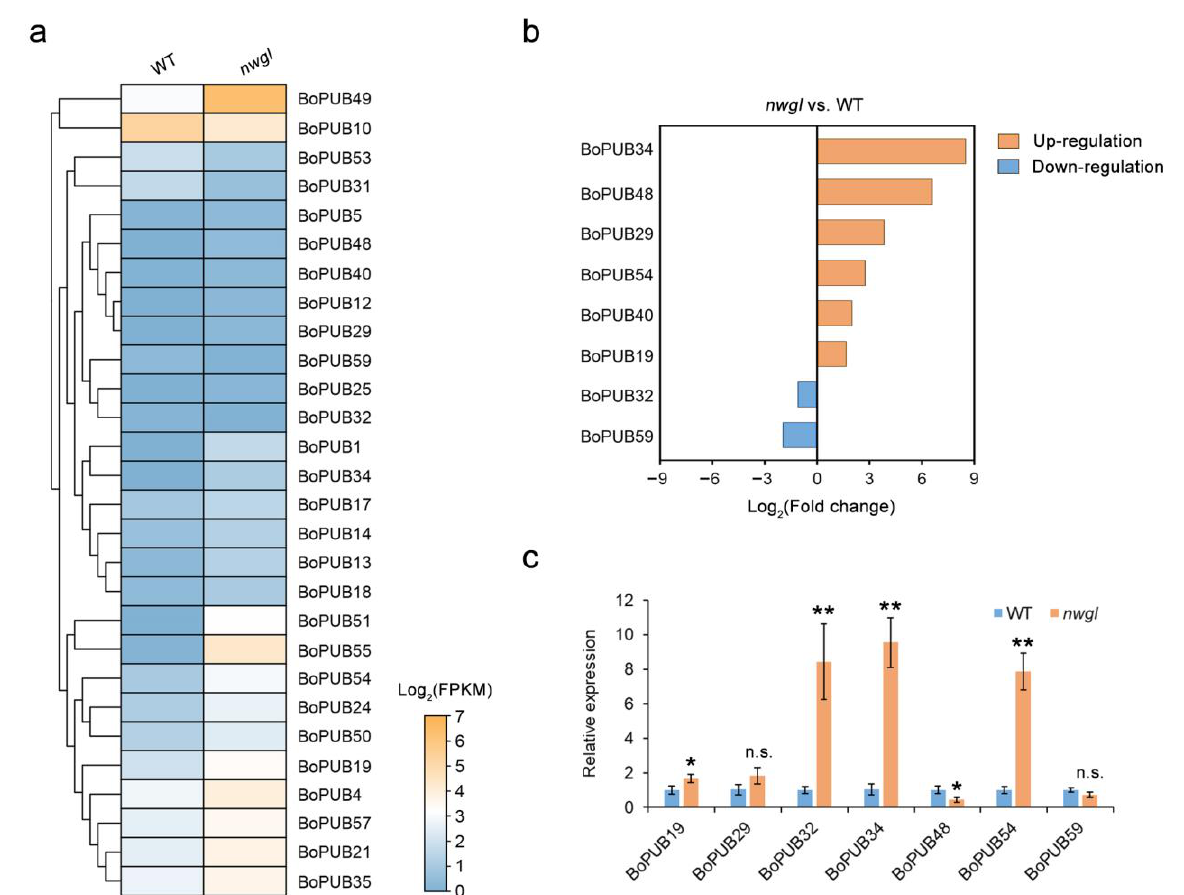
10 of 22 Figure 6. Expression profiles of BoPUB genes in various tissues and organs. The normalized expres- sion data, as fragments per kilobase per million mapped reads (FPKM), of BoPUB genes in seven tissues, including callus, root, stem, leaf, bud, flower, and silique, were obtained from the RNA-seq data of cabbage ( Brassica oleracea var. capitata ). The expression levels of BoPUB genes were plotted in a log2-scaled heatmap. Each row and column in the color heatmap indicate a single gene and tissue, respectively, and their names are shown. Sixty-five BoPUB genes are hierarchically clustered into six groups (Groups I–VI) according to their expression levels. Groups I–VI are highlighted in six different colors, respectively. 2.7. Expression Patterns of BoPUB Genes Involved in Cuticular Wax Biosynthesis E3 ubiquitin ligases have been widely reported to regulate cuticular wax biosynthesis in many species, including Arabidopsis thaliana [38,39] and Oryza sativa [40]. To understand whether BoPUB genes are involved in cuticular wax biosynthesis, the transcript levels of BoPUB genes in cabbage leaves from cuticular wax-deficient mutant non-wax glossy ( nwgl ) and its wild-type (WT) were analyzed based on RNA-seq data previously reported (Fig- ure 7a) [41]. The results indicated that eight BoPUB genes were differentially expressed between nwgl and WT leaves (Figure 7b). Of these genes, the transcript levels of six BoPUB genes ( BoPUB19 , 29 , 34 , 40 , 48 , and 54 ) were up-regulated, and those of two BoPUB genes ( BoPUB32 and 59 ) were down-regulated (Figure 7b). The transcription of BoPUB34 was